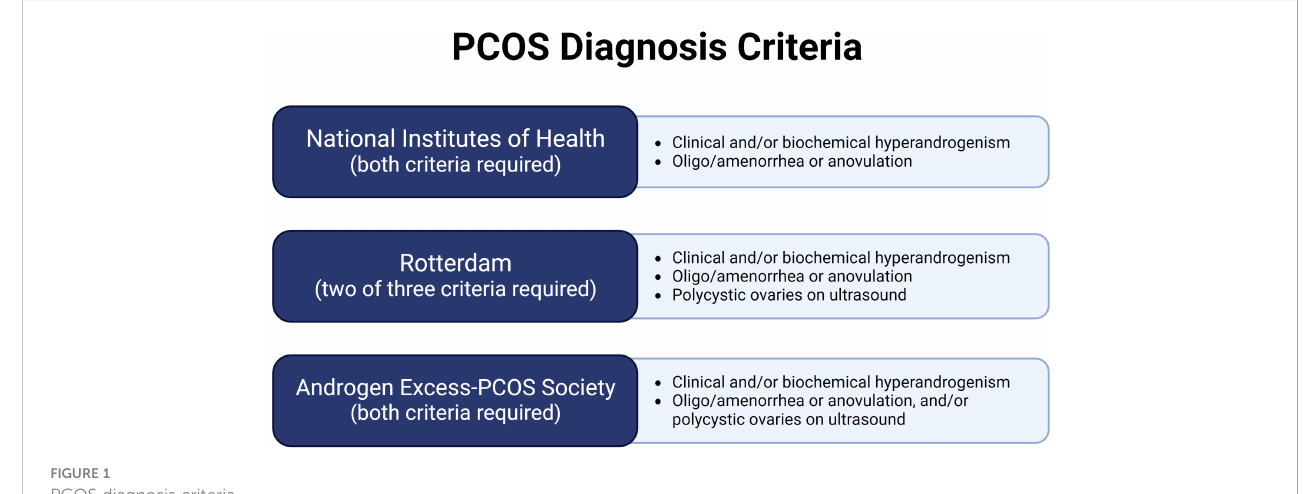
FIGURE 1 PCOS diagnosis